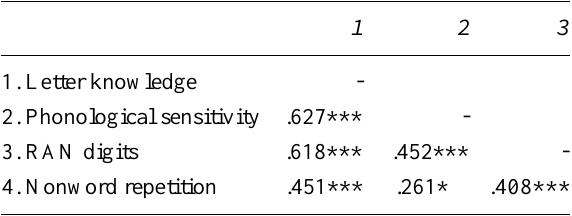
Correlations among Tasks at the Beginning of